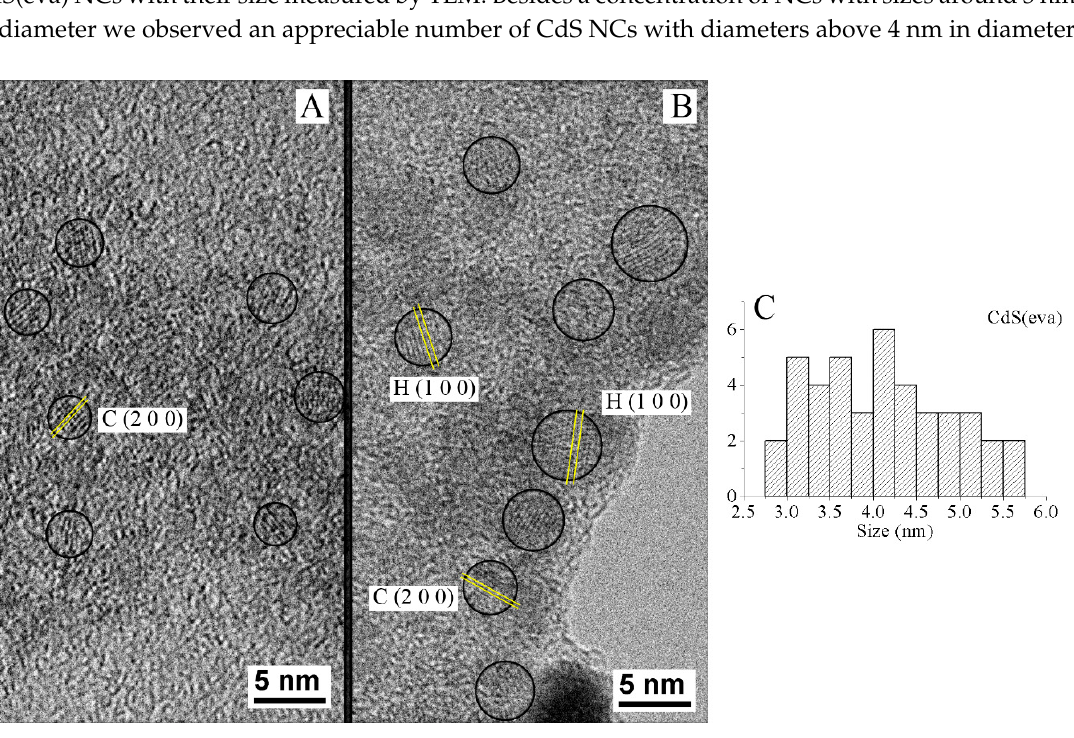
Figure 8. TEM images corresponding to ( A ) CdS(col) NCs and ( B ) CdS(eva) NCs. ( C ) Histogram for the calculation of the mean size and particle size distribution for CdS (eva) NCs.